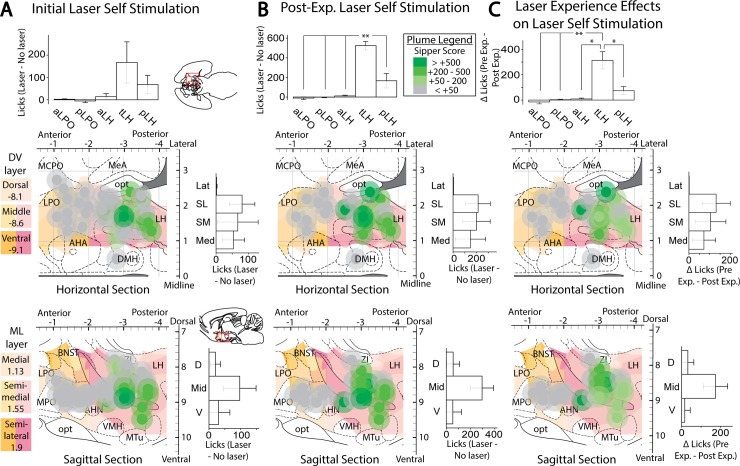
Anatomical localization of spout-touch self-stimulation.Fos plume maps demonstrating spout-touch laser self-administration in ChR2 rats prior to (A), after (B), and magnitude of change due to (C) extended laser exposure. Data depicts spout touch score–the difference of laser-associated spout touches minus alternative non-laser spout touches. Figure conventions and abbreviations are the same as the prior mapping figures. Bar graphs represent spout-touch difference scores (average laser licks minus average non-laser licks) for each LH site. *: p < 0.05, **: p < 0.01.